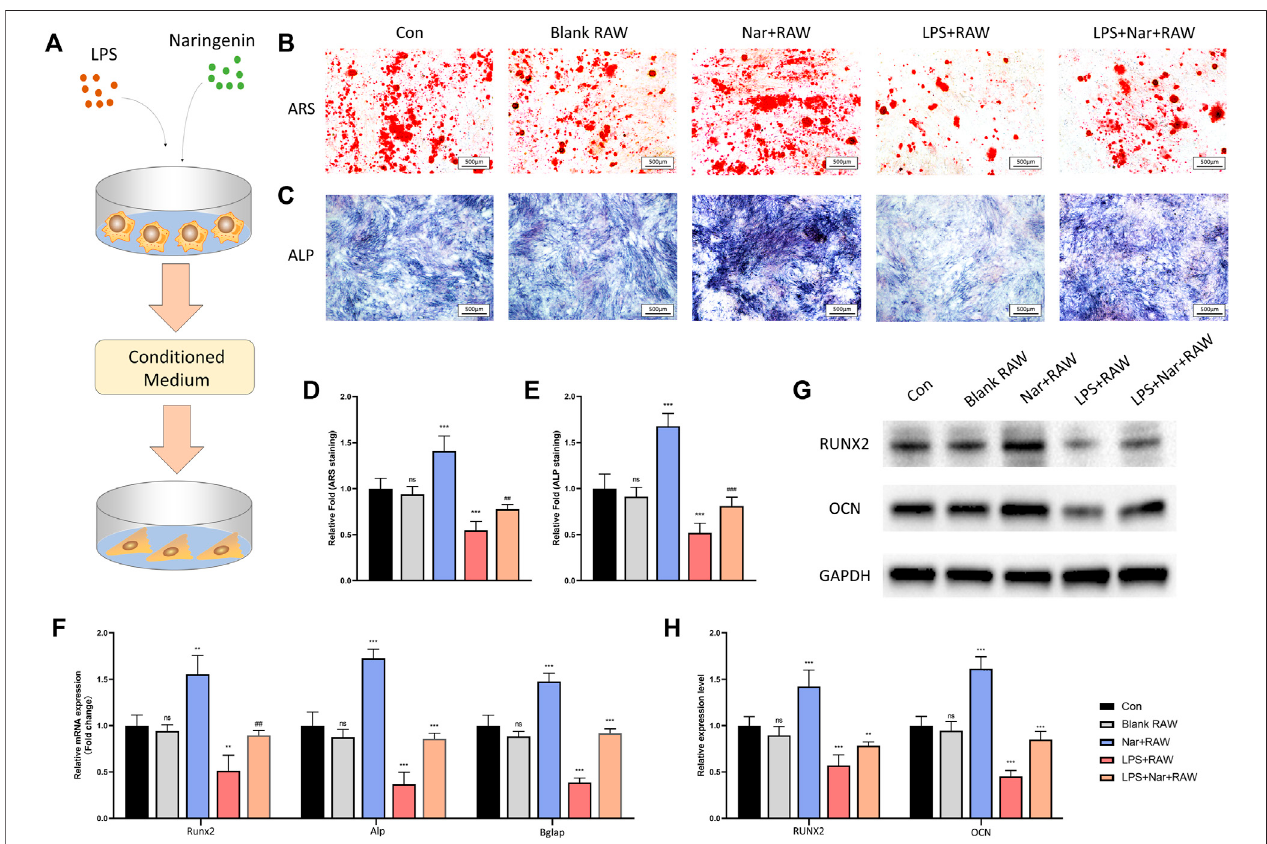
FIGURE 5 | Osteogenesis is enhanced under naringenin-modulated macrophage coculture medium. (A) Schematic illustration. (B,D) ARS staining and its quanti fi cation. (C,E) ALP staining and its quanti fi cation. (F) Transcript levels of osteoclast markers Acp5, CtsK, and Dc-stamp. (G, H) Western blot and optical density analysis of RUNX2 and OCN with GAPDH as reference. n = 4 per group. Data are expressed as mean ± SD. * # p < 0.05; ** ## p < 0.01; *** ### p < 0.001. * compared with con group; # compared with LPS + RAW